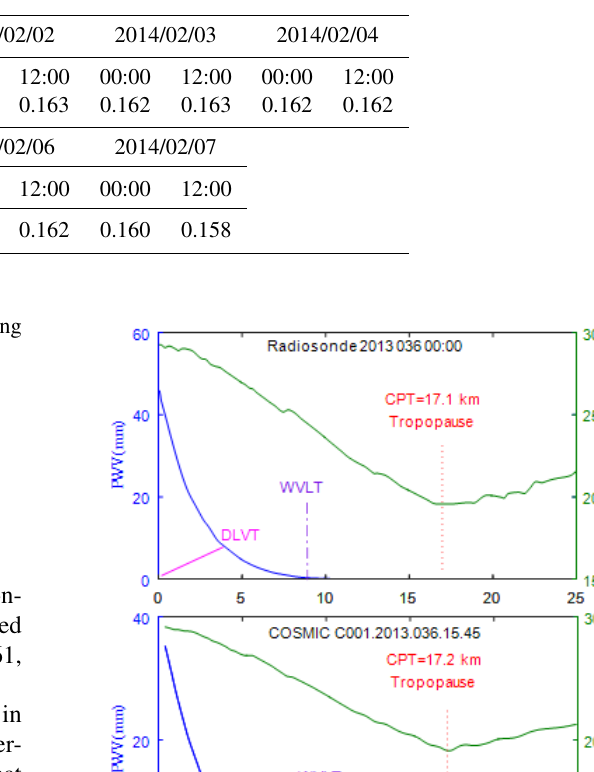
Table 2. Derived humidity conversion factor for consecutive 7 days using improved method. Date format is YYYY/MM/DD.